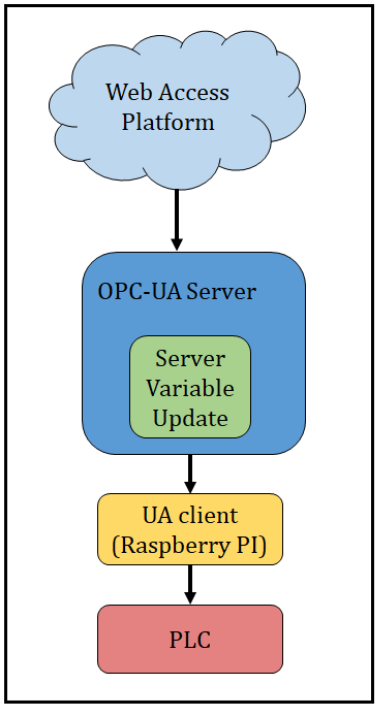
Figure 11. Web Access Platform (WAP) to Programmable Logic Controller (PLC) signal travel time experiment